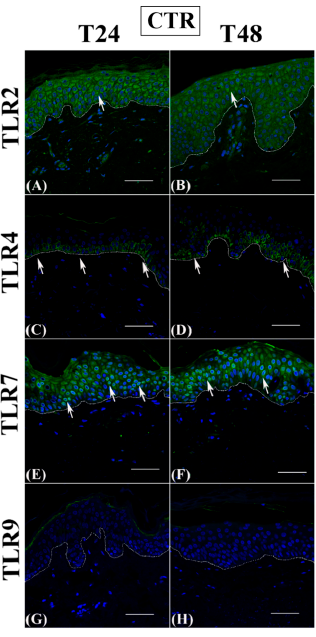
Figure 3. TLR2, TLR4, TLR7, and TLR9 immunofluorescence analysis on paraffin human skin sections. Representative TLR2 ( A , B ), TLR4 ( C , D ), TLR7 ( E , F ), and TLR9 ( G , H ) immunostainings in normal human skin paraffin sections. ( A , C , E , G ): samples harvested at 24 h; ( B , D , F , H ): samples harvested at 48 h. ( A – H ): control samples. Nuclei are counterstained with DAPI. TLR2: Toll-like receptor 2; TLR4: Toll-like receptor 4; TLR7: Toll-like receptor 7; TLR9: Toll-like receptor 9; DAPI: 4 ′ , 6-diamidino-2-phenylindoledihydrochloride. White dotted line indicates the basal membrane. White arrows indicate positive immunostaining—scale bars: 50 μ m. TLR2 immunostaining was reduced transiently only in IL-13-exposed samples after 24 h (Figure 4C), while it was comparable in all other cytokine-exposed samples at both time points (Figure 4, panels A, B, and D; Figure 5, panels A–D), similarly to controls (see Figure 3, panels A and B).